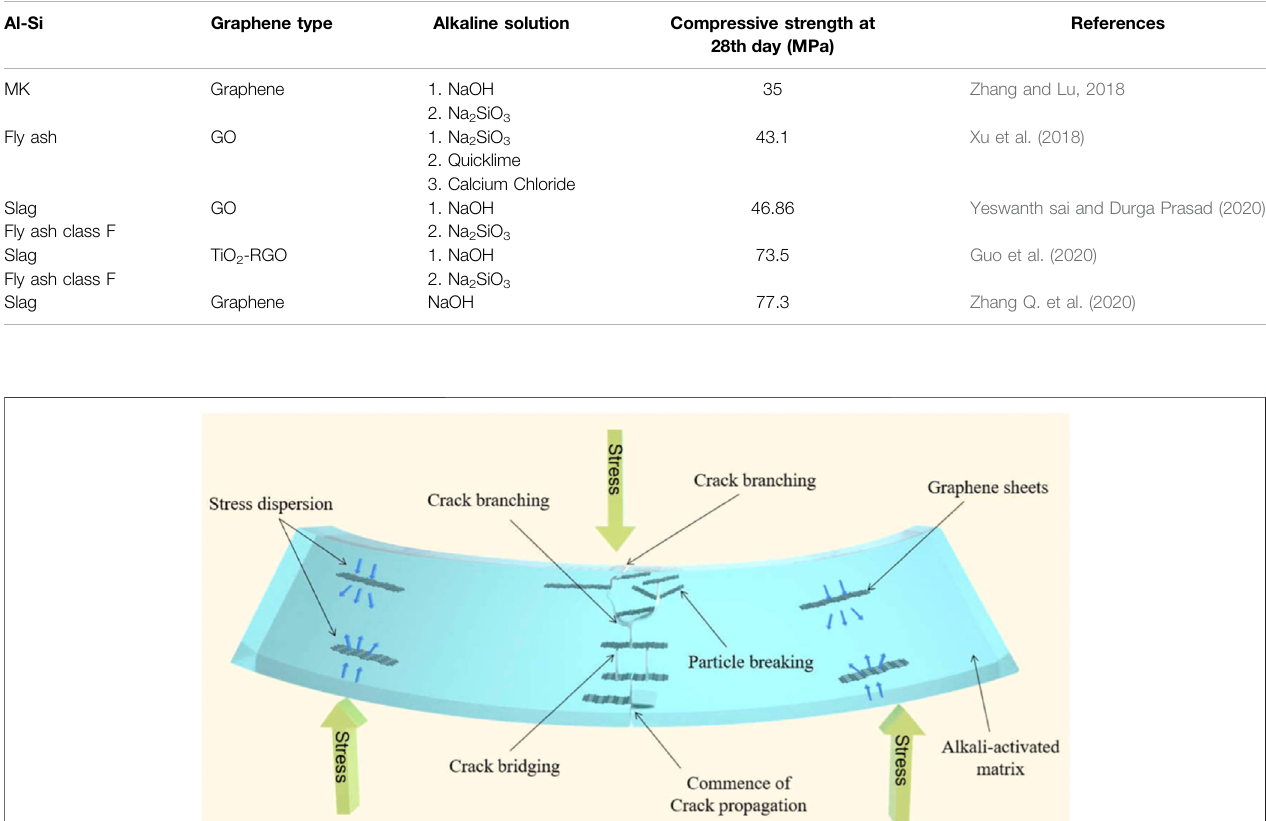
Frontiers in Materials |